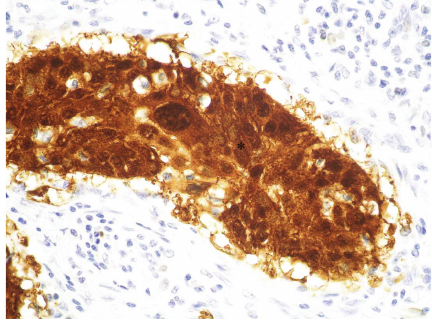
Figure 14: Case 4—histological view of the tumor after immune- histochemical staining against p16. The brown signal ( ∗ ) proves the infection with